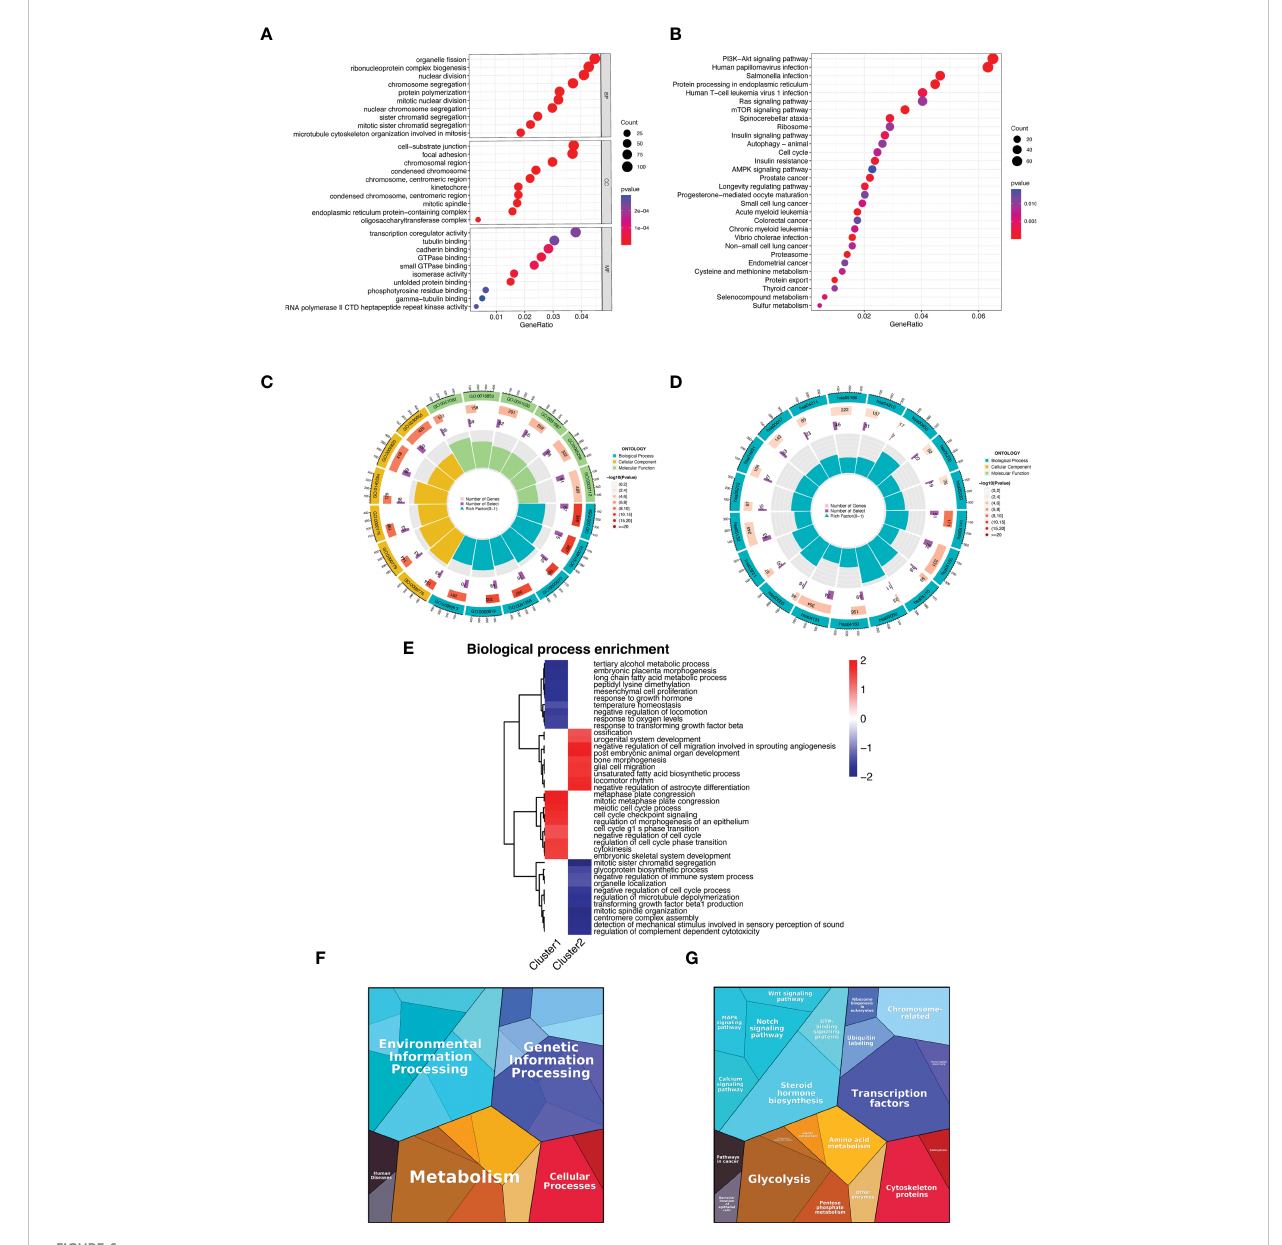
FIGURE 6 Functional enrichment analysis. (A, C) GO enrichment analysis of DEGs between fi broblasts of different subtypes. (B, D) KEGG enrichment analysis of DEGs between fi broblasts of different subtypes. (E) GSEA enrichment analysis of biological functions between two clusters. (F, G) Functional categories of differentially expressed genes between fi broblasts of different